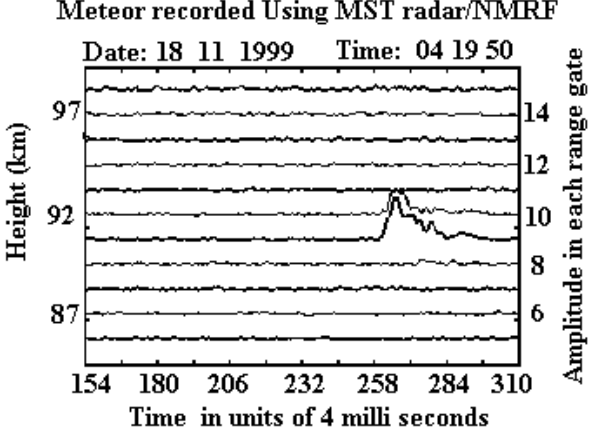
Fig. 1. Time variation of MST radar echo from a typical under- dense Meteor